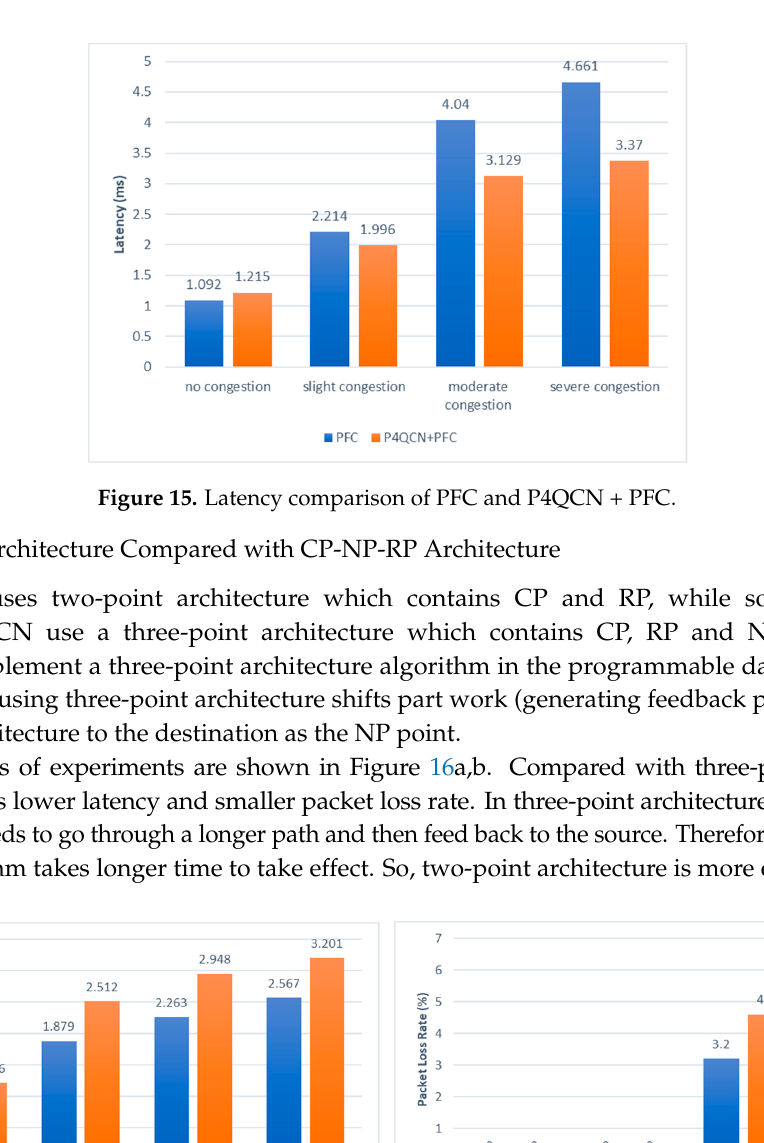
Figure 16. ( a ) Latency comparison of 2-point and 3-point; ( b ) Packet loss comparison of 2-point and 3-point.